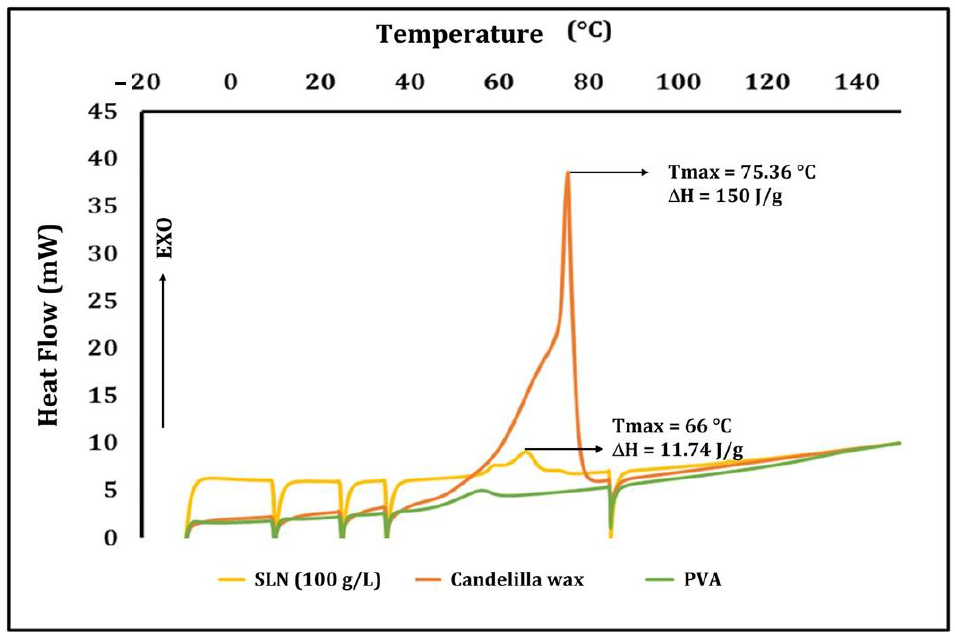
Figure 1. Thermal behavior of raw materials used to form SLN dispersions (100 g/L).